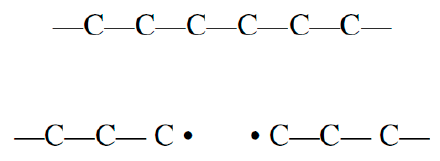
Figure 4. LDPE degradation mechanism [32].